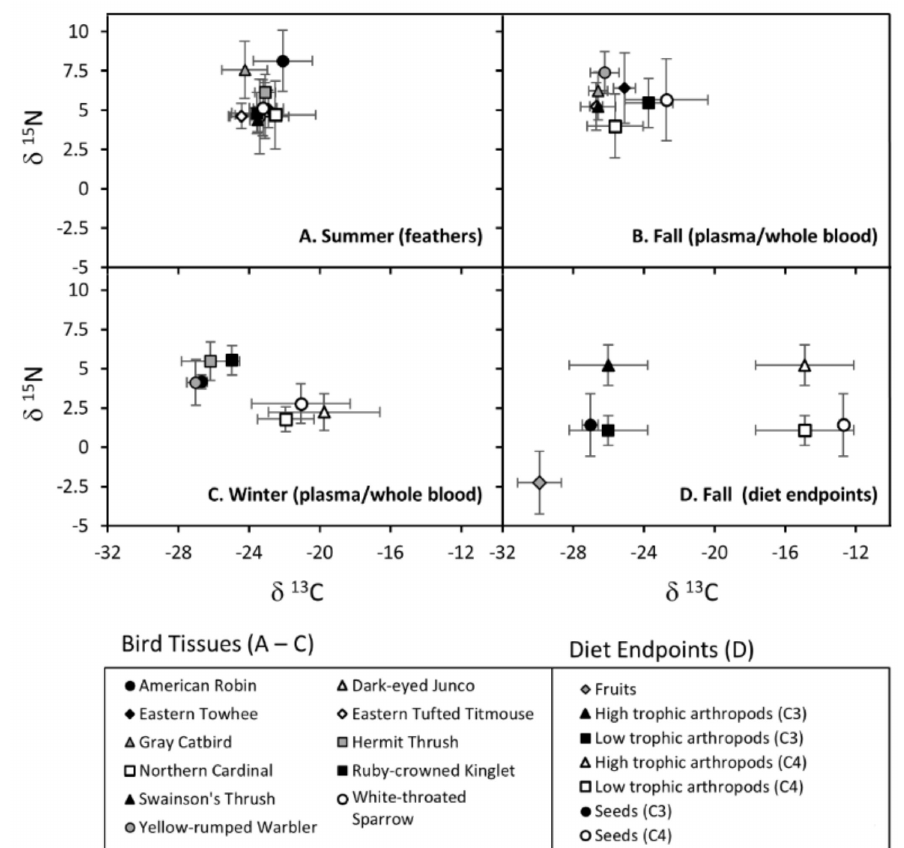
Figure 2. Seasonal community-level patterns in 15 N and 13 C isotopic space of ( A ) bird feathers grown during the late summer months and consequently influenced by late summer diet and ( B ) blood (Ruby-Crowned Kinglet only) and plasma (all other species) collected during the fall and ( C ) winter months. Note the broad overlap between species in isotopic values from feathers, indicating similar diets among species in summer, and the increasingly divergent values in fall and especially in winter. The dietary endpoint graph ( D ) is provided as a reference and, when compared to the isotopic values of bird tissues in the winter, suggests that birds increased the use of fruit (lower δ 15 N values in the winter) and seeds (more positive δ 13 C values during the